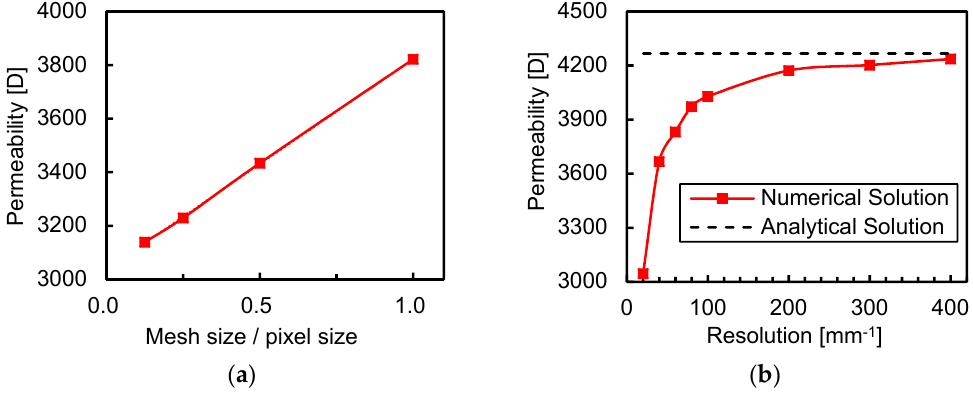
Figure 7. Validation result for BCC unit. ( a ) Linear dependence of calculated permeability on mesh size for BCC-N20; ( b ) Convergence to analytical value of extrapolated permeability with increasing resolution.